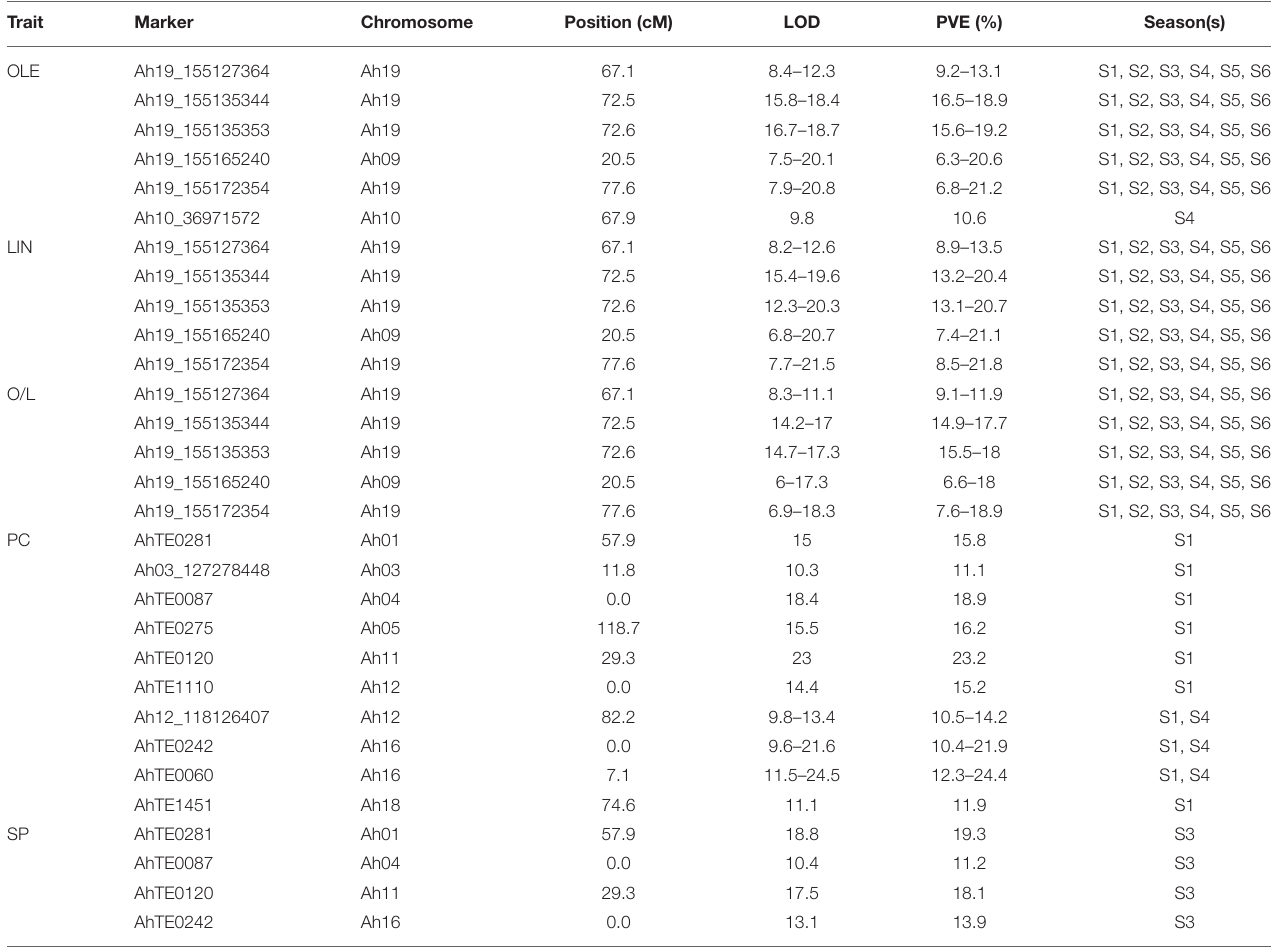
TABLE 2 | Major SNP and AhTE markers identified using single marker analysis for the productivity and quality traits in the RIL population of TMV 2 and TMV 2-NLM of peanut. Trait Marker Chromosome Position